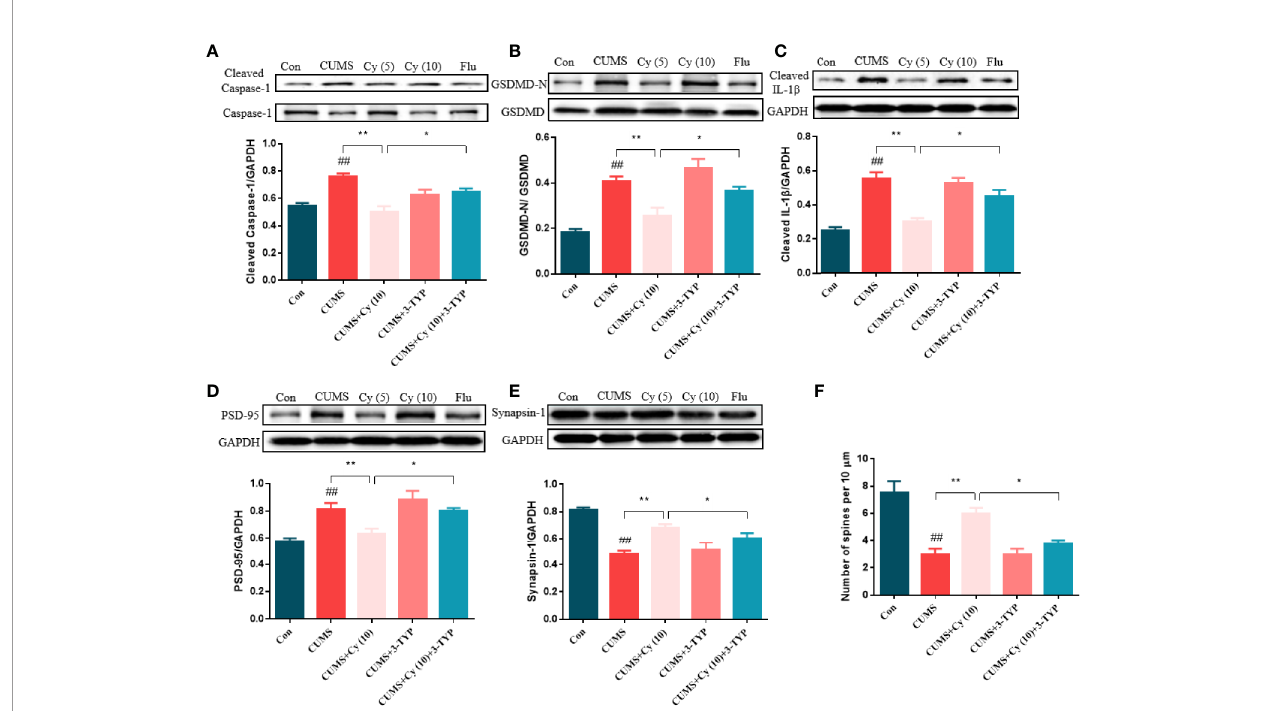
FIGURE 6 | Effect of SIRT3 blockage on Cy-related improvements of NLRP3 in fl ammasome and neuroplasticity. Cy generated restoration of NLRP3 in fl ammasome proteins Caspase-1 (A) , GSDMD (B) , IL-1 b (C) , and enhancement of PSD-95 (D) , Synapsin-1 expression (E) as well as dendritic spine density (F) were all abolished when co-administrated with SIRT3 inhibitor 3-TYP. Data are represented as mean ± SEM. ## p < 0.01 vs. Con group. * p < 0.05 and ** p < 0.01 vs. CUMS + Cy (10 mg/kg)